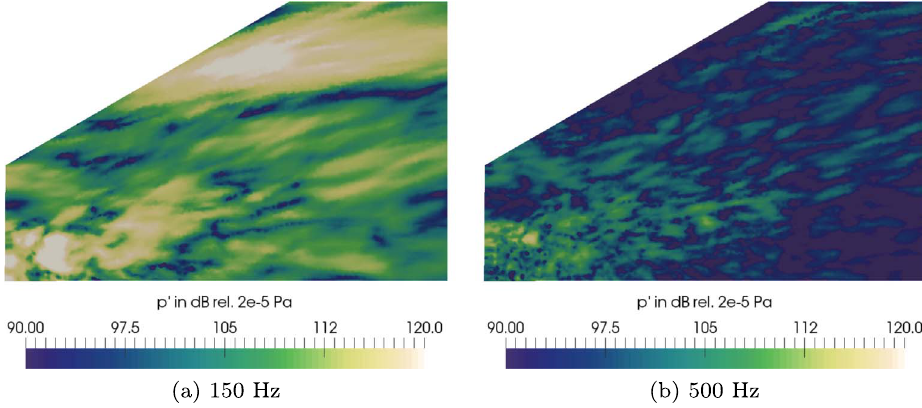
Figure 9. Aerodynamic pressure distribution on surface from CFD simulation at different